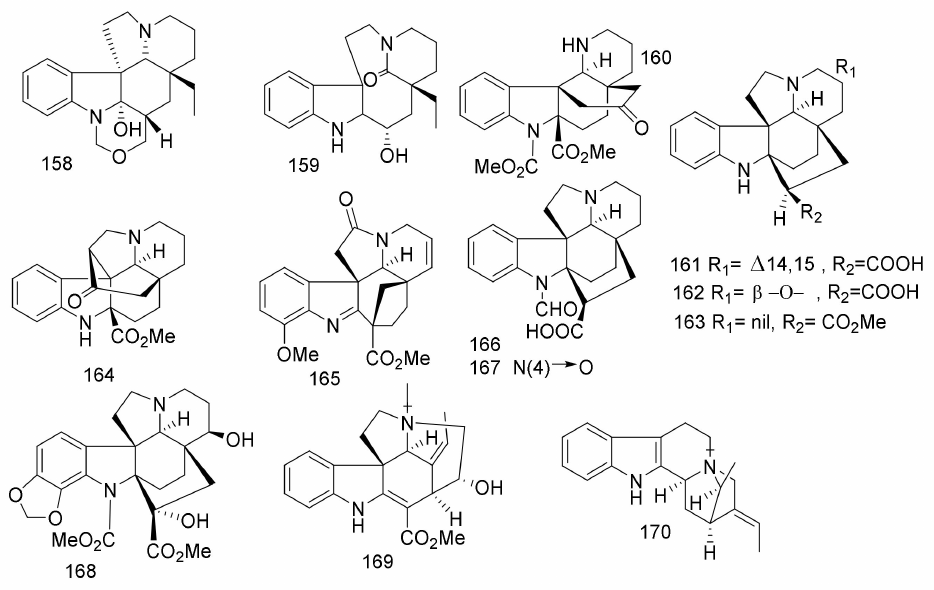
Figure 18. Compounds 158 – 170